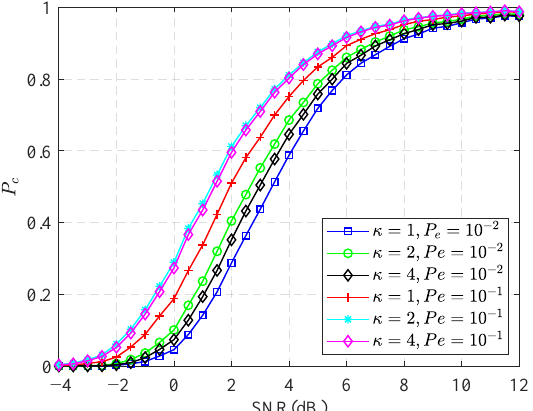
Figure 10. P e Probability of correct decision in the interference